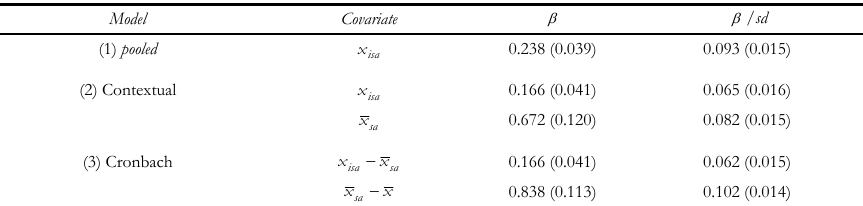
Tuscan Longitudinal Study. Regression coefficients (standard error) of census block average material deprivation index. Results of the individual-level models (1) (2) (3) (see text). All cause mortality.